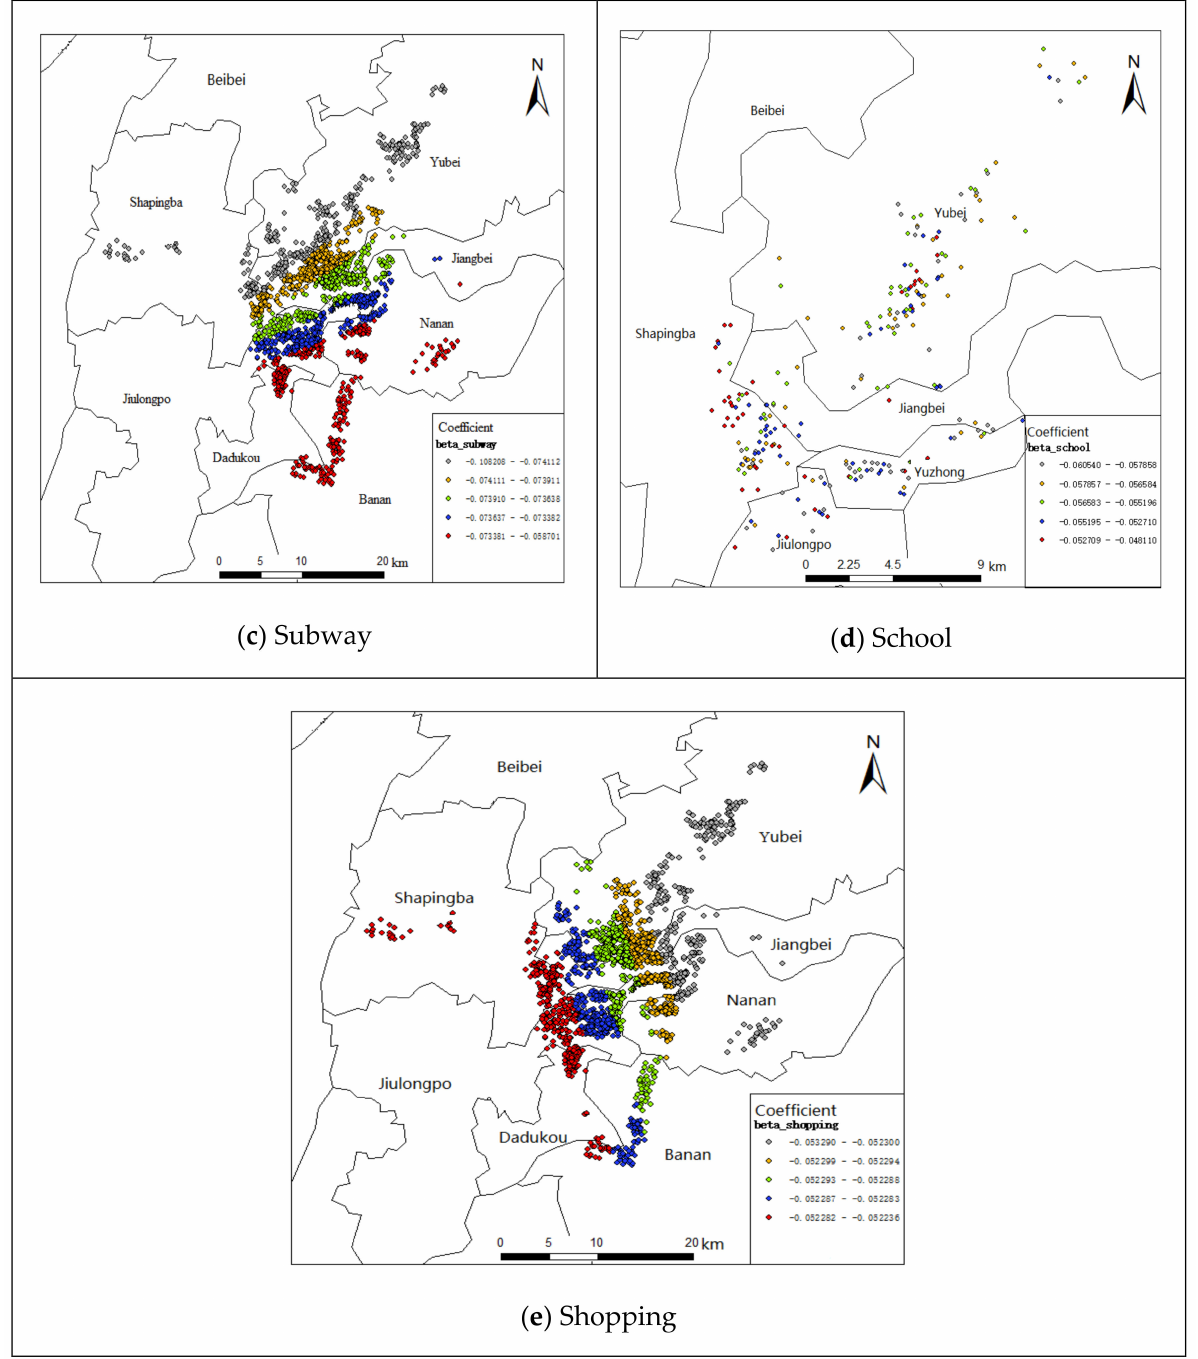
Figure 3. Spatial distribution of the local influential factors for the private housing rental prices in eight central urban districts of